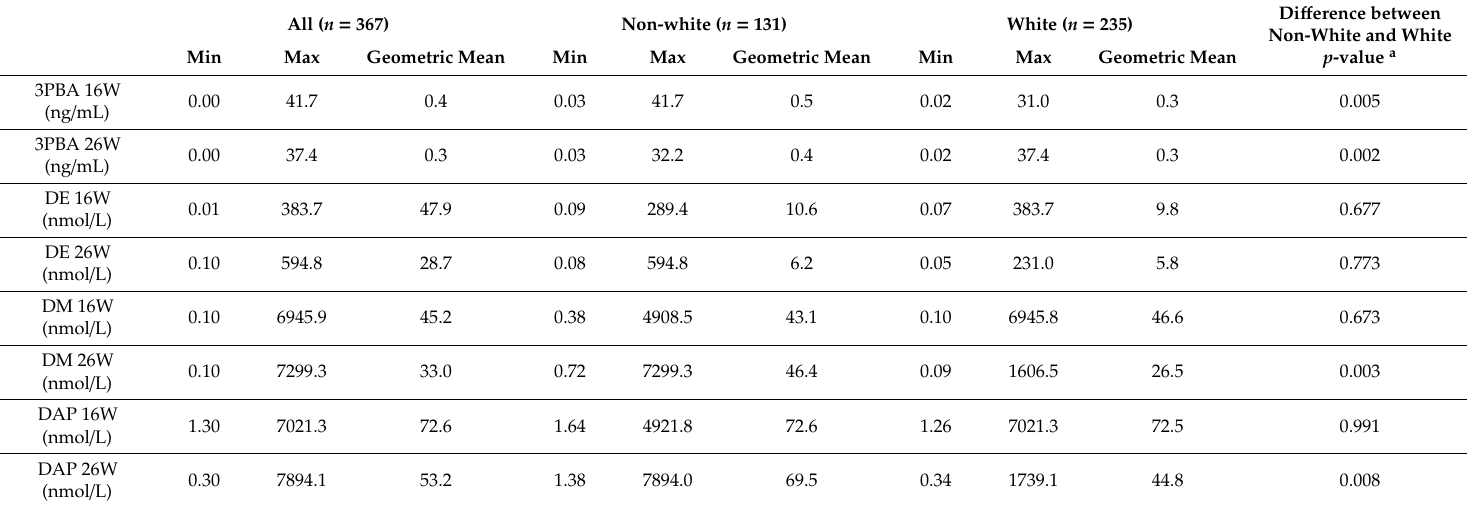
Table 2. Gestational urinary pesticide metabolite concentrations by race at 16 and 26 weeks